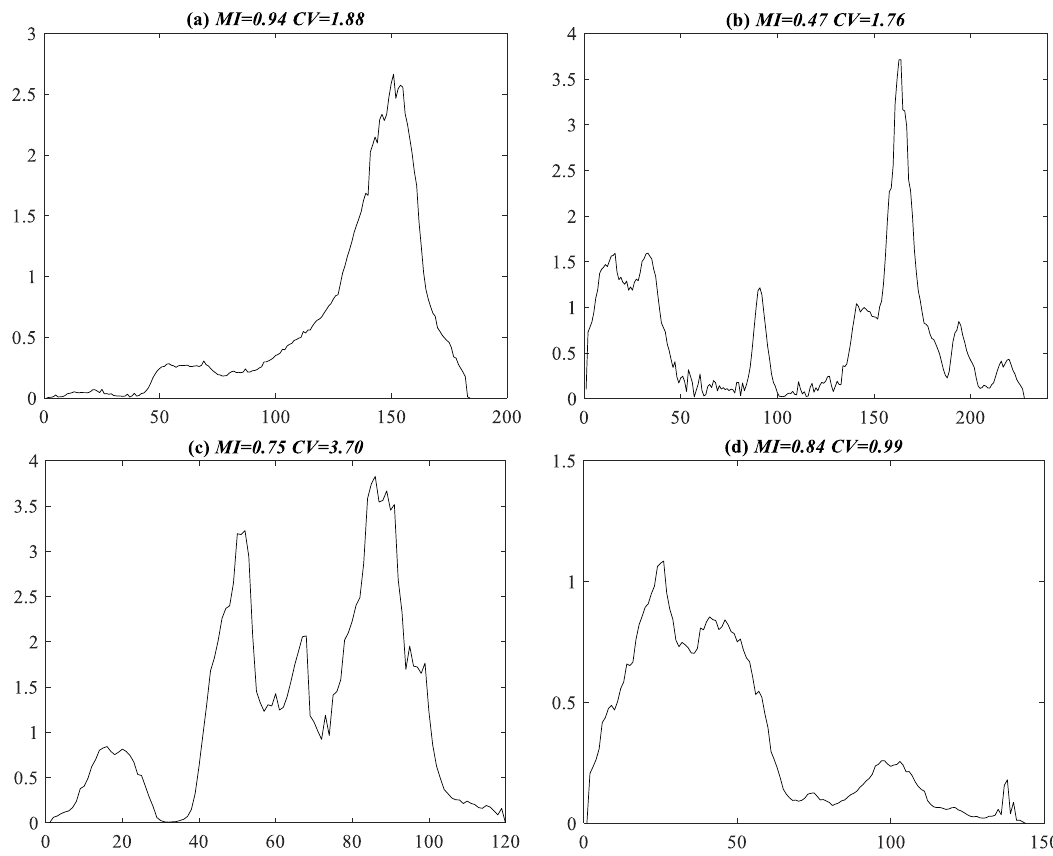
Figure 3. Radar rainfall estimates for four events with different temporal rainfall variability. ( a ) MI = 0.94, CV = 1.88, ( b ) MI = 0.47, CV = 1.76, ( c ) MI = 0.75, CV = 3.70, ( d ) MI = 0.84, CV = 0.99.